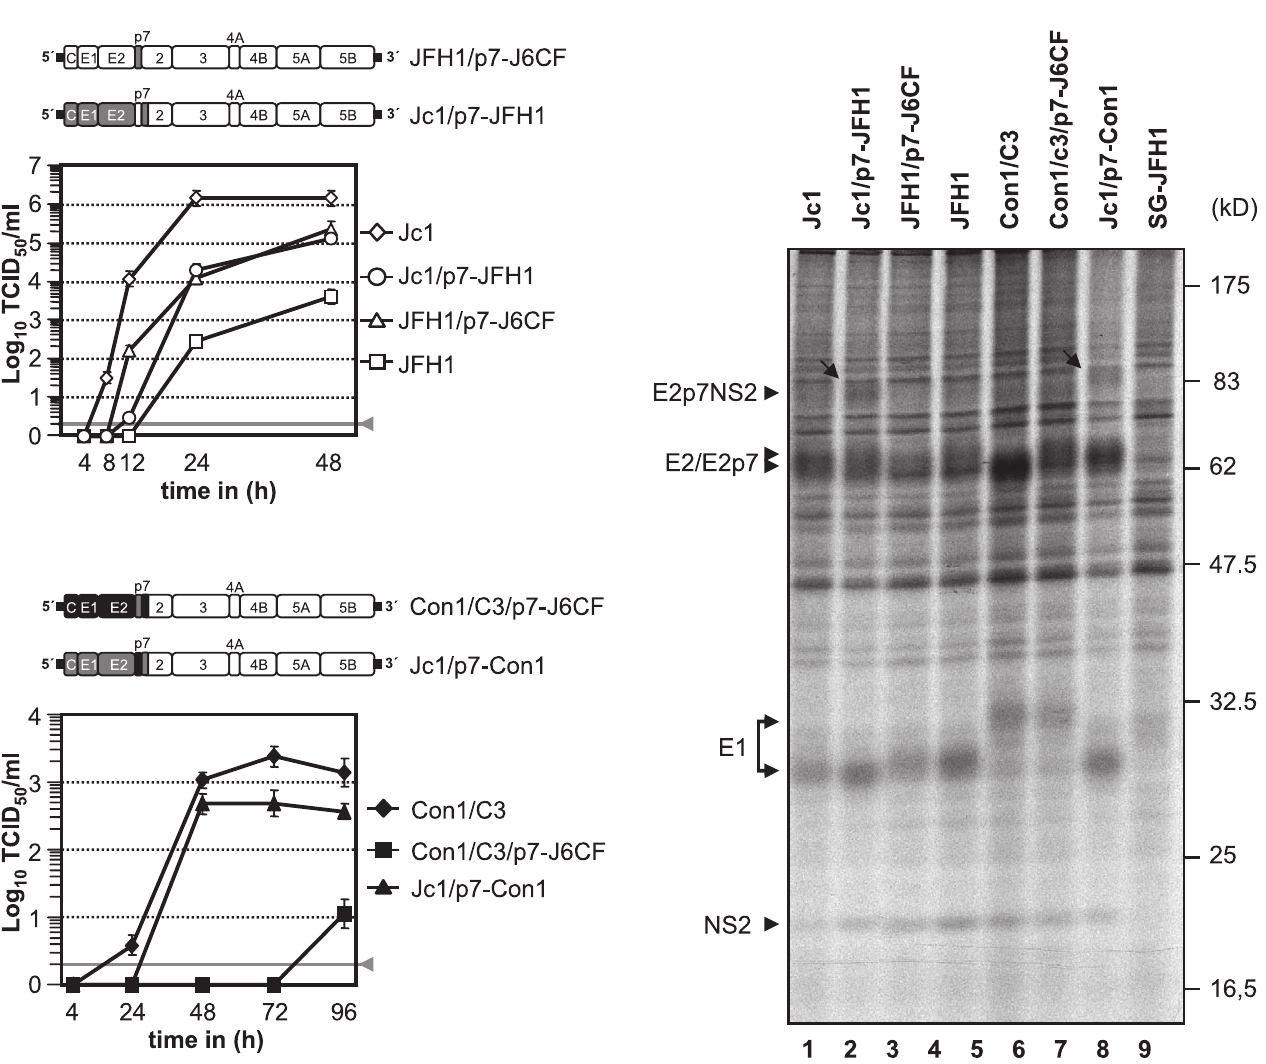
Figure 7. Processing of the E2-p7-NS2 Region of JFH1, Jc1, Con1/C3, and Various Chimeras Huh-7.5 cells were transfected with indicated constructs. 24 h post- transfection, cells were labeled with [35S] methionine/cysteine-contain- ing medium overnight and then lysed immediately. HCV proteins were immunoprecipitated using an antibody monospecific for E2. The positions of the molecular weight standard are given on the right. Arrowheads to the left point to the respective precursors and mature HCV proteins detected. Arrows within the figure point out alterations in protein processing. Note that Con1-derived E1 displays a lower electro- phoretic mobility than E1 from JFH1 and J6CF.